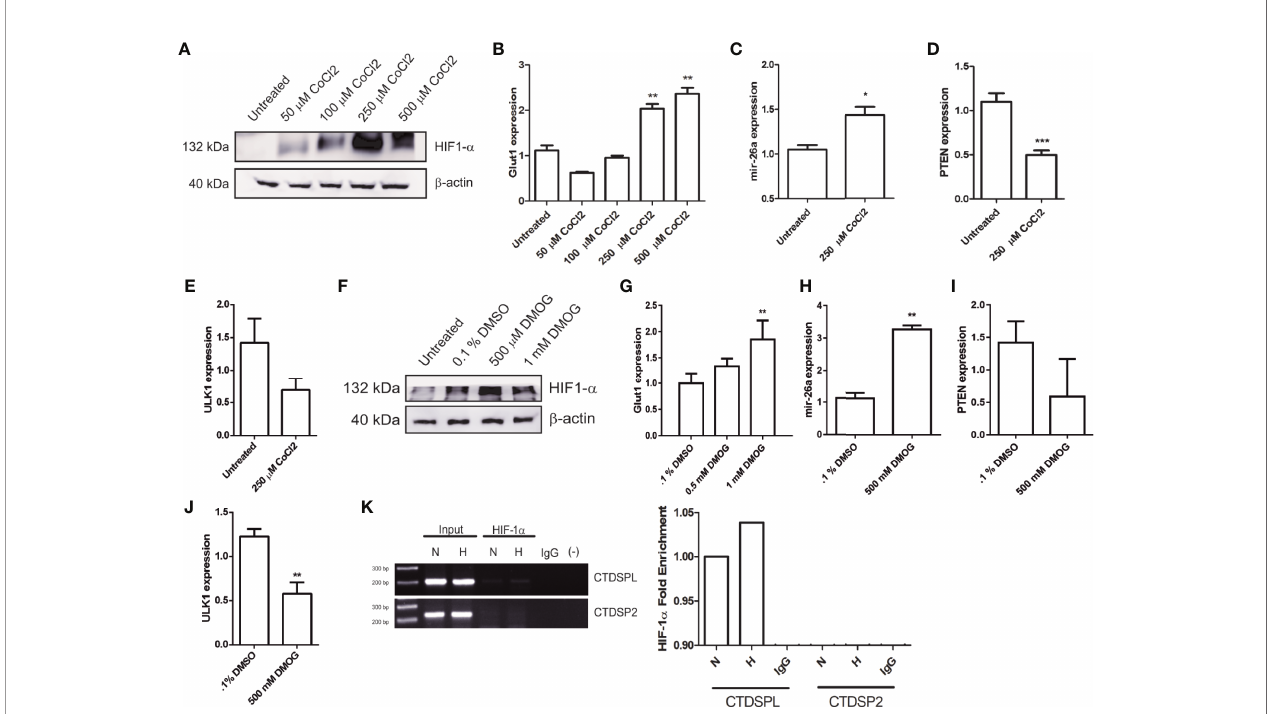
FIGURE 5 | HIF-1 a promotes mir-26a expression. (A) Protein detection of HIF-1 a by western blot in HCT116 cells treated with 50, 100, 250 and 500 m M of CoCl 2 at 24 h. (B) Glut1 expression in cells treated with different concentrations of CoCl 2 . (C – E) Expression of mir-26a, PTEN and ULK1 in cells treated with CoCl 2 (250 m M). (F) Detection of HIF-1 a by western blot after DMOG treatments. (G – J) expression of GLUT1, mir-26a, PTEN and ULK1 treated with DMOG. (K) ChIP assay of HIF-1 a in CTDSPL and CTDSP2 promoter under CoCl 2